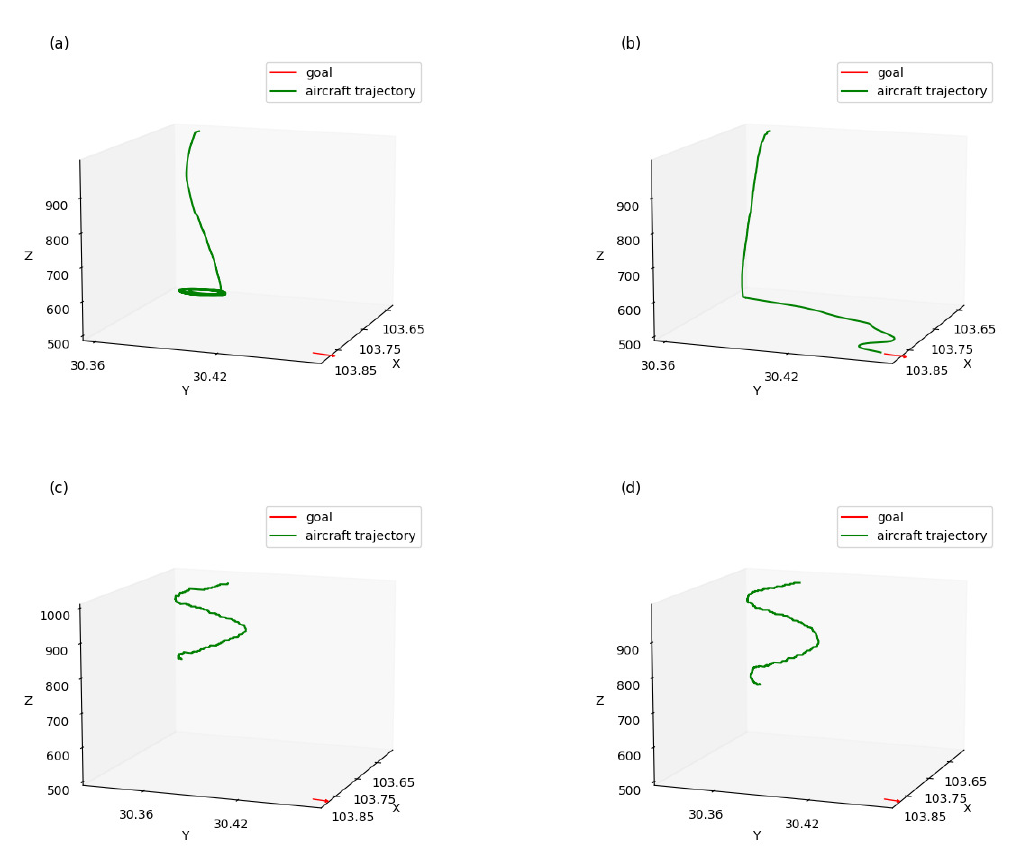
Figure 13. Trajectories of aircraft considering arrival time: ( a ) multi-layer approach without reward shaping; ( b ) multi-layer approach with reward shaping; ( c ) not layered approach without reward shaping; and ( d ) not layered approach with reward